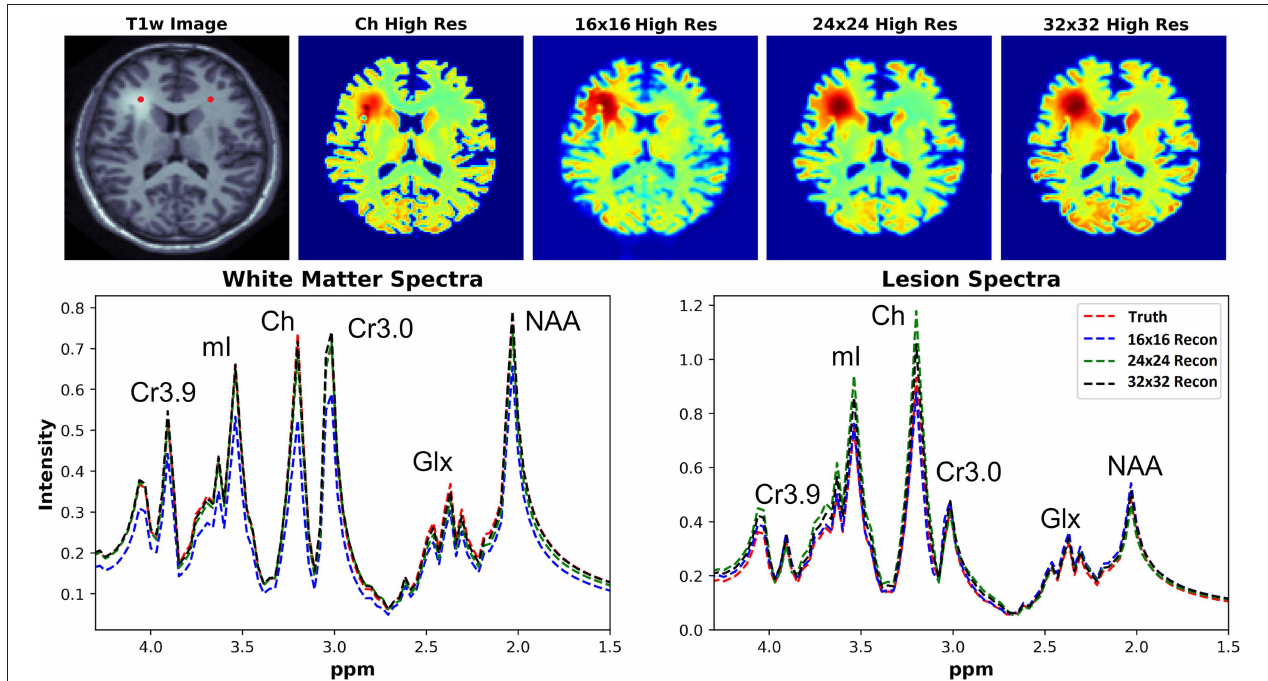
FIGURE 7 | Magnitude spectral reconstructions using the three D-UNets are shown for two voxels. The voxel locations for the white matter and lesion spectra are displayed in the T1w image as red points. The spectra generated from the ground truth (red), the 16x16 (blue), 24x24 (green), and 32x32 D-UNets (black) for the 1.5–4.3 ppm range are displayed. For spatial comparison, the choline metabolite maps for each method are also shown. All metabolite maps are scaled from 0 to 1. The 24x24 and 32x32 D-UNet reconstructions over-estimate the amount of choline in the lesion. However, the 16x16 reconstruction under-estimates the amount of metabolite signal in the healthy white matter